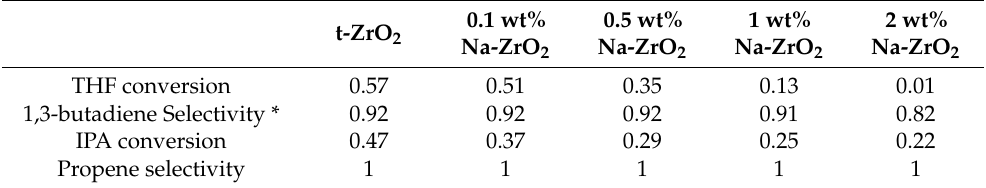
Table 1. Conversion and selectivity for reaction of THF (WHSV = 1.86 g THF/g cat/h, 673 K) and IPA (WHSV = 1.55 g IPA/g cat/h, 598 K). 0.1 wt% t-ZrO 2